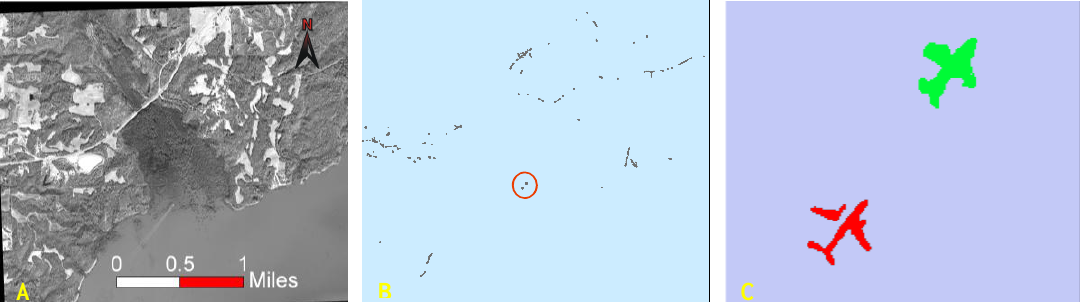
Figure 7. A 16-km 2 scene of lake and countryside (a). After image differencing and sieving; the red circle contains an aircraft in flight (b) , and a zoom of red circle, possible Boeing 737 scenes (c)